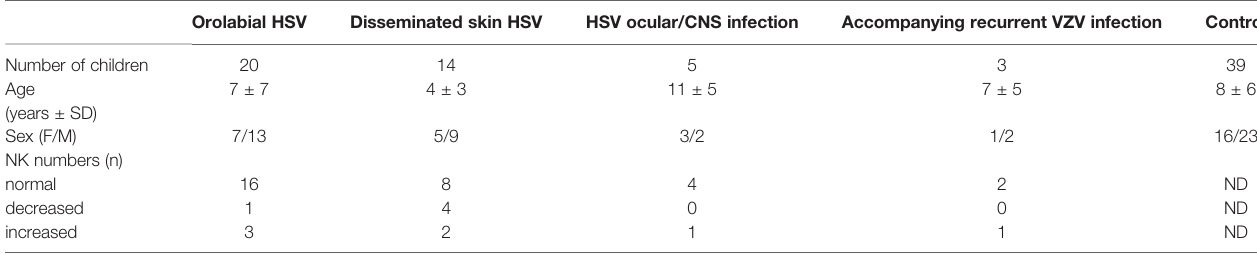
TABLE 1 | Characteristic of patients and control